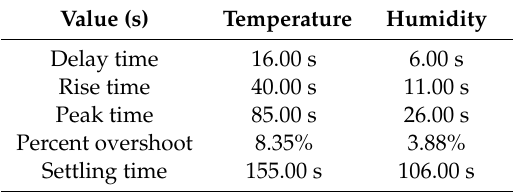
Table 4. Atmospheric enclosure system responses to some characteristic